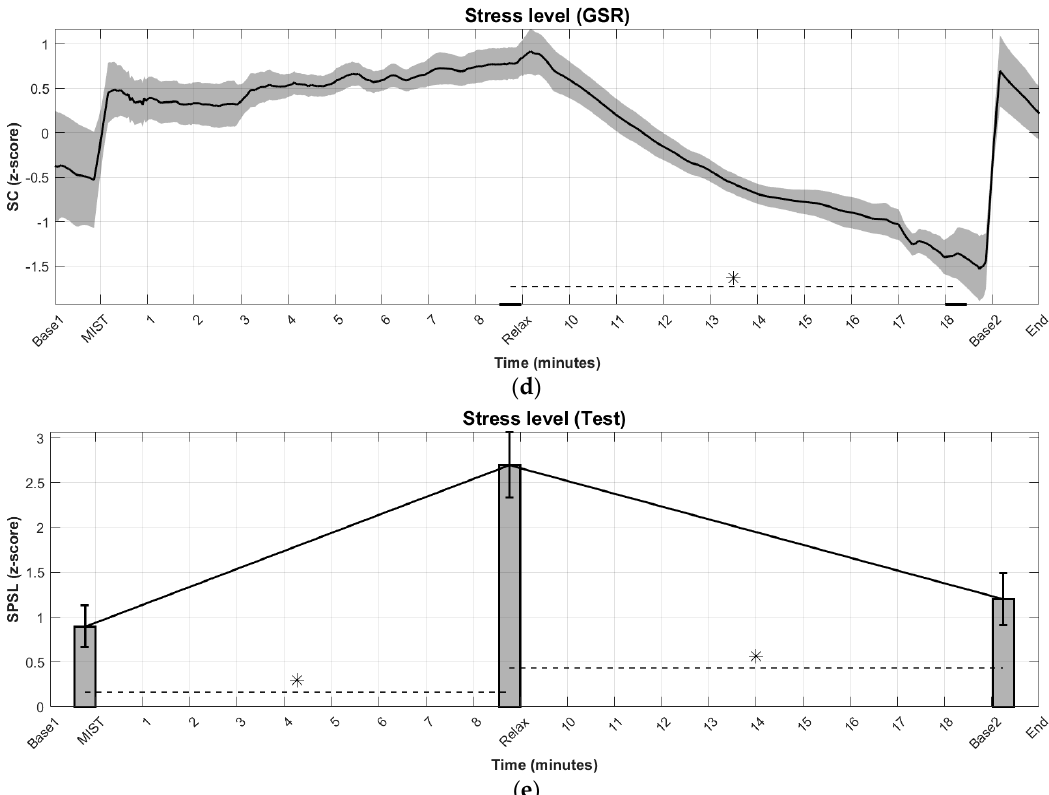
Figure 4. Grand-average across subjects of the time evolution of processed stress markers in the regions of interests. Base1 and Base2 correspond to the central minutes of resting state blocks RS1 and RS2, respectively. MIST indicates the beginning of the stress session (3 min of training and 6 min of task). Relax indicates the beginning of the relaxing session. Shades behind the plots and error bars indicate the standard error of the mean (SEM): ( a ) relative gamma (RG) estimated from electroencephalography (EEG) data; ( b ) average heart rate (HR) estimated from electrocardiography (ECG) data; ( c ) trapezius activity (TA) estimated from electromyography (EMG) data. Asterisk indicates statistically significant difference ( p -value < 0.05) in average TA between the last 30 s of the stress session and the second-to-last 30 s of the relaxing session; ( d ) skin conductance (SC) estimated from galvanic skin response (GSR) data. Asterisk indicates statistically significant difference ( p -value < 0.05) in average SC between the last 30 s of the stress session and the second-to-last 30 s of the relaxing session; ( e ) self-perceived stress level (SPSL) obtained from questions at T1, T2, and T3 points. X-axis only comprises regions of interests and T1, T2, and T2 would actually be located before the stress session (i.e., just before MIST), after the stress session (i.e., just after minute 9), and after the relaxing session (i.e., just after minute 19), respectively. Asterisks indicate statistically significant difference ( p -value < 0.05) in SPSL between the T1–T2 and between T2–T3. In addition, the Pearson’s correlation coefficient (PCC) between stress markers and the corresponding 95% confidence interval is reported in Table 1. Table 1. Pearson’s correlation coefficient (PCC) between processed stress markers and the corresponding lower (CI low) and upper (CI up) bounds for a 95% confidence interval (CI).